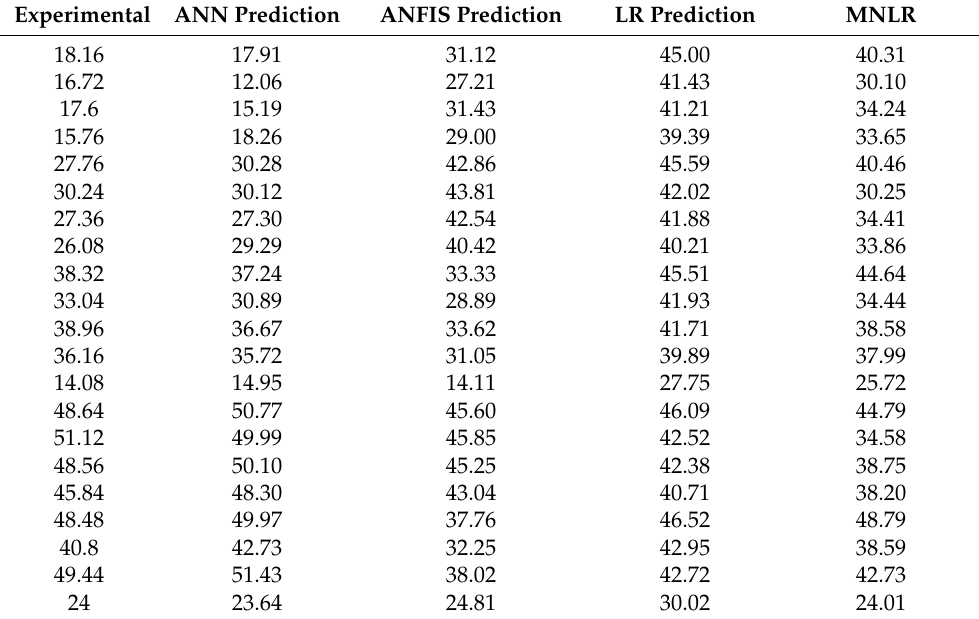
Table A1. Compressive strength (CS) (MPa) results obtained through different